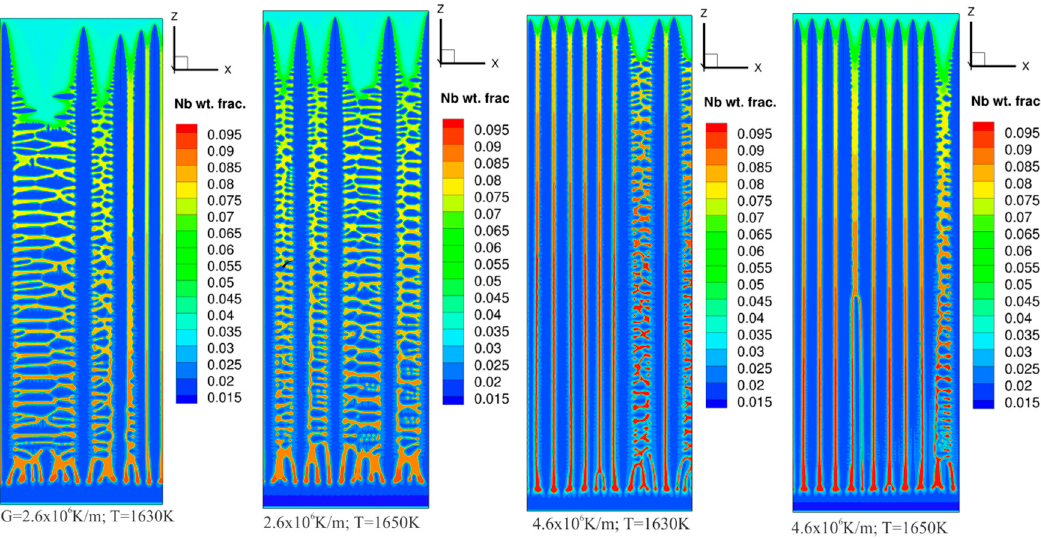
Figure 14. Effect of increasing the diffusion coefficient to 2 × 10 − 9 m 2 /s on the dendrite